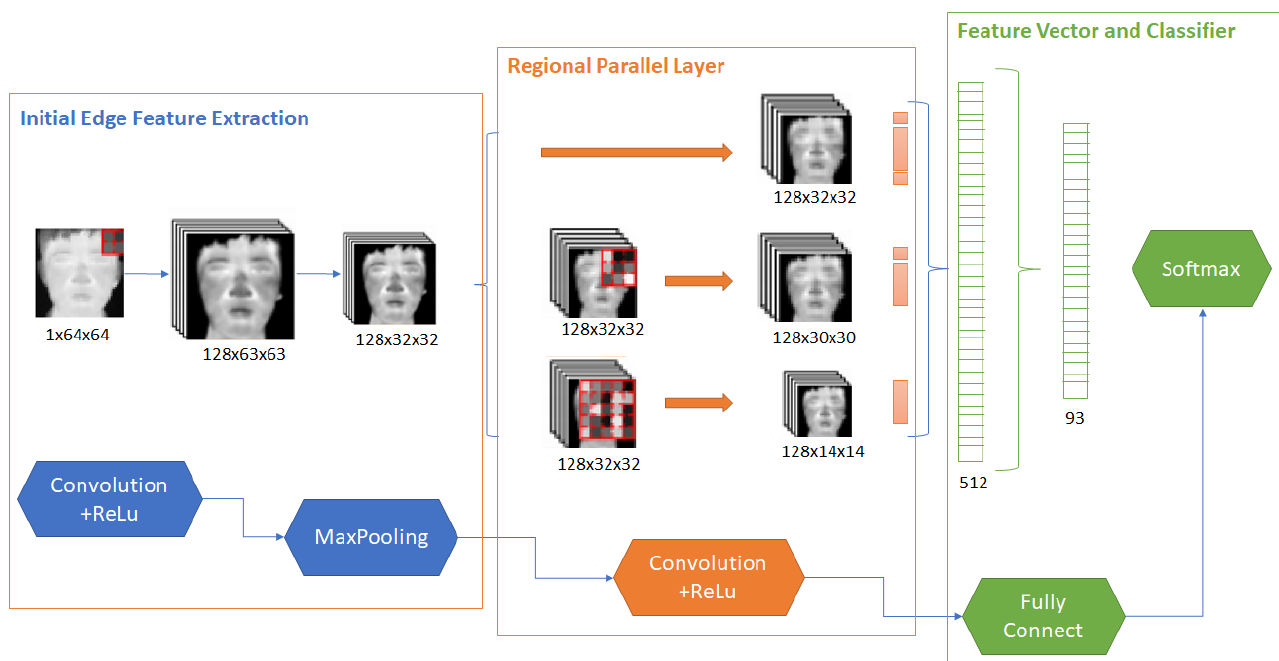
Figure 12. Regional parallel structure convolutional neural network based on [113].